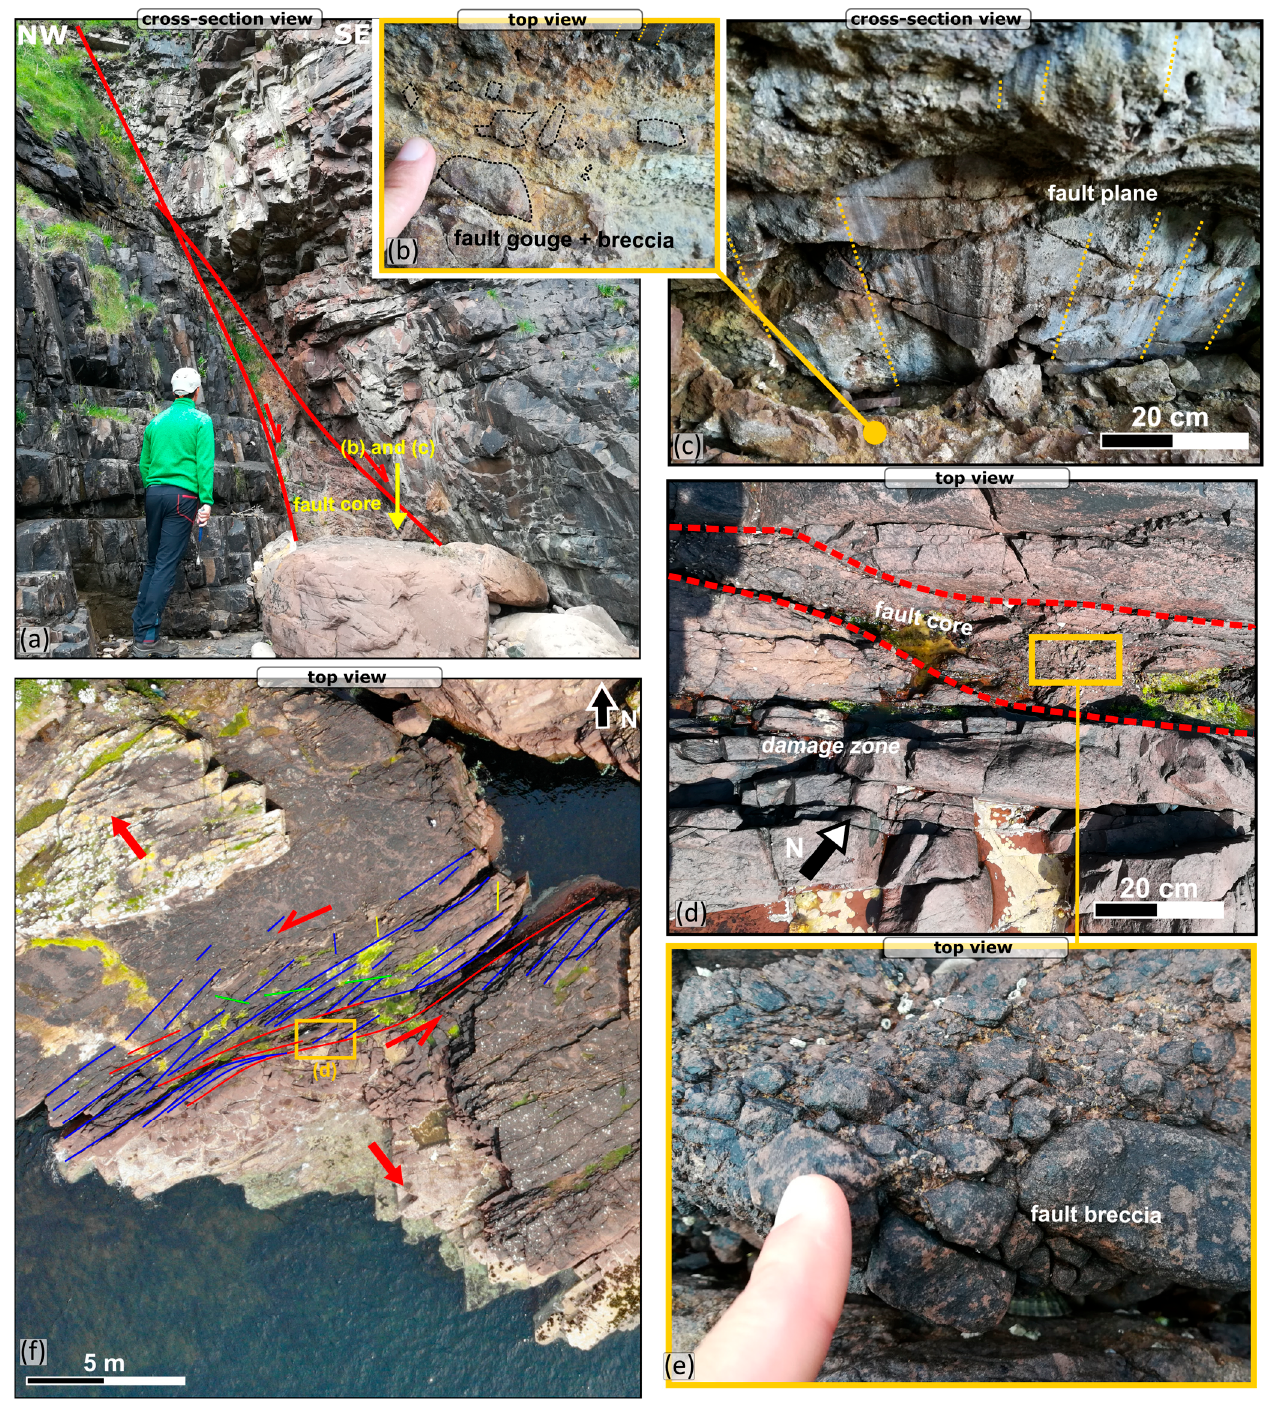
Figure 8. Field photographs of ( a ) a major NE–SW-trending fault present in the cliffs at Muiri Geo (see location on Figure 4b); ( b , c ) detailed view of the associated fault rock; and dip-slip lineations and grooves (yellow dotted lines) on the NE–SW-trending fault. ( d ) Fault core and ( e ) detail of fault breccia associated with ( f ) a major NE–SW-trending fault present at The Haven, note the wide highly damaged zone with en-echelon fractures array showing sinistral